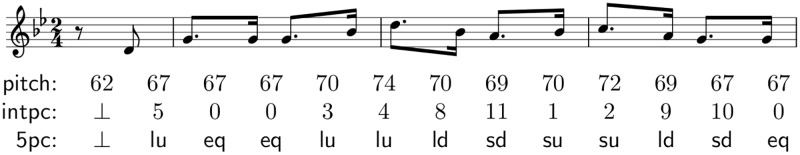
Viewpoint representation.Viewpoint representation of the first two bars of the melody Abiatu da bere bidean.